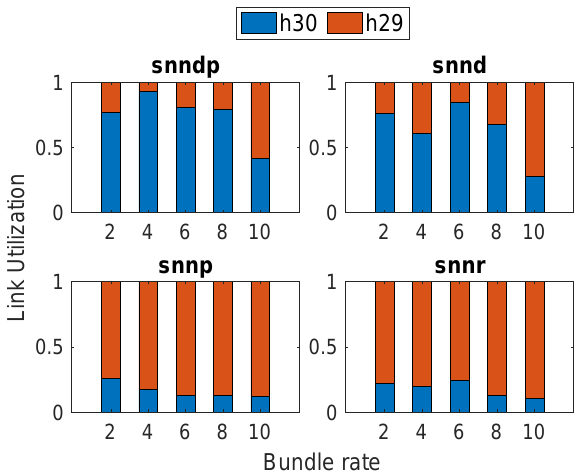
Figure 14. Link selection at Node h26: Scenario 6.